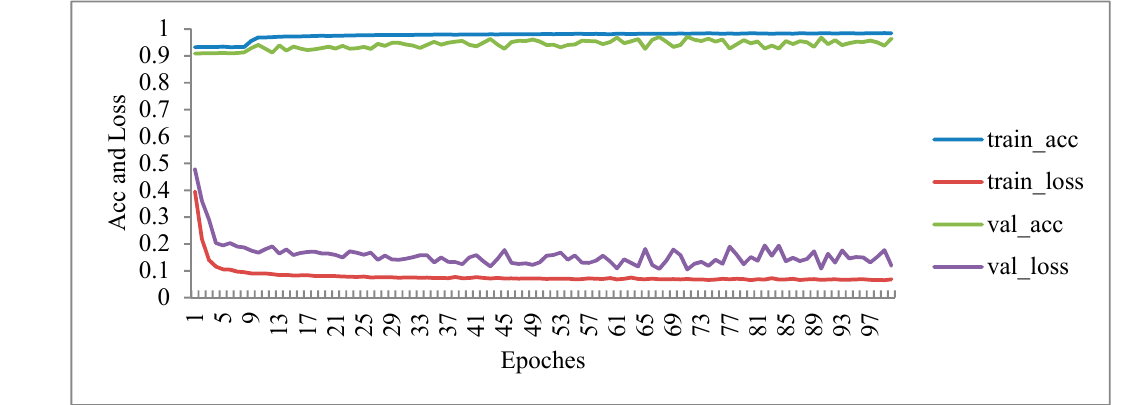
Figure 11. Accuracy and loss curves for the training process.